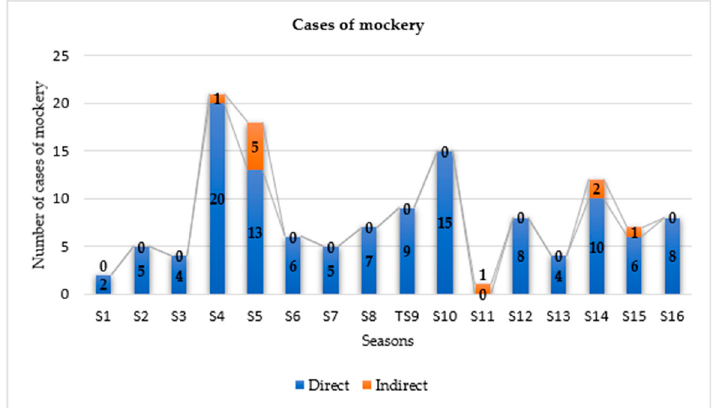
Figure 2. Cases of mockery. Source: Own elaboration.